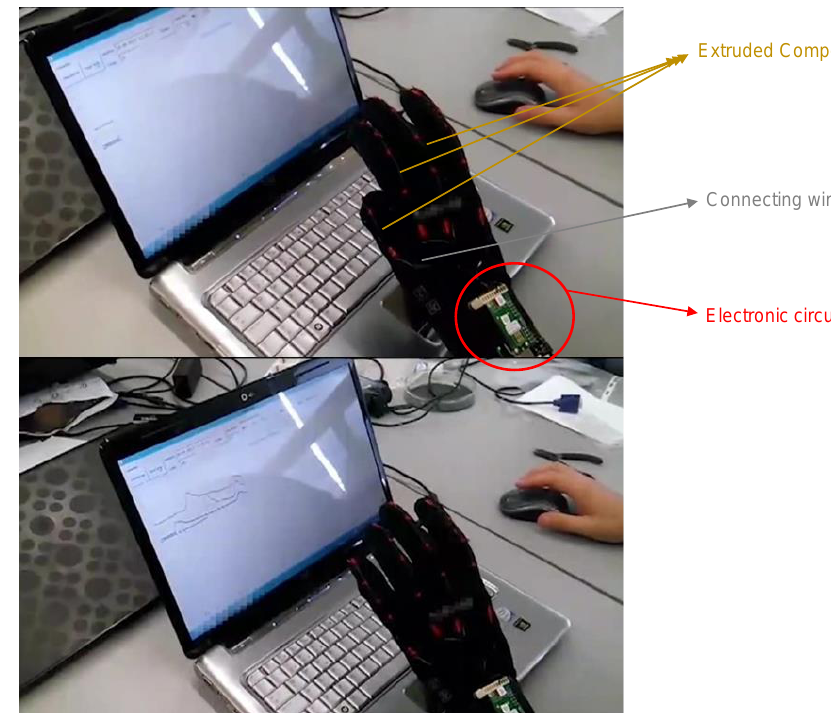
Figure 23. Piezoresistive sensors integrated into the glove.